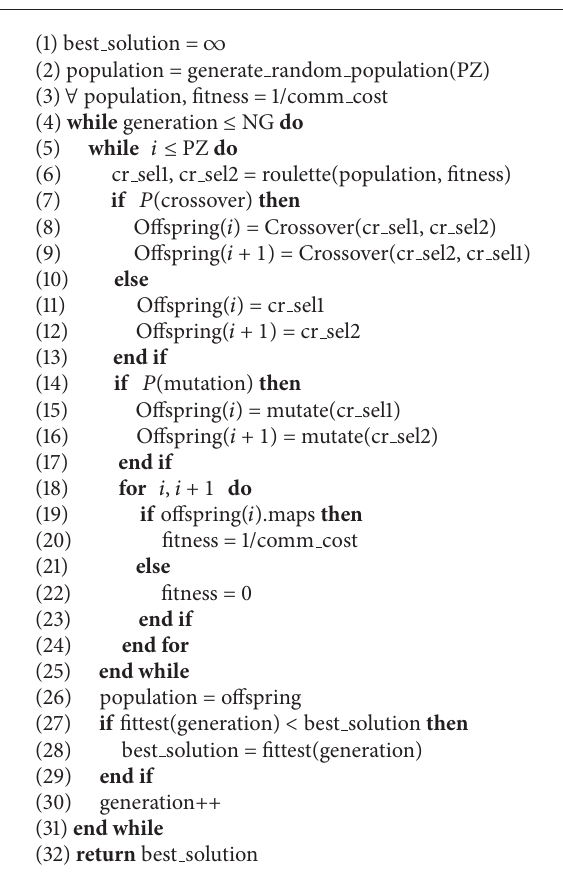
Algorithm 1: Pseudocode of a GA for reconfigurable placement and mapping in